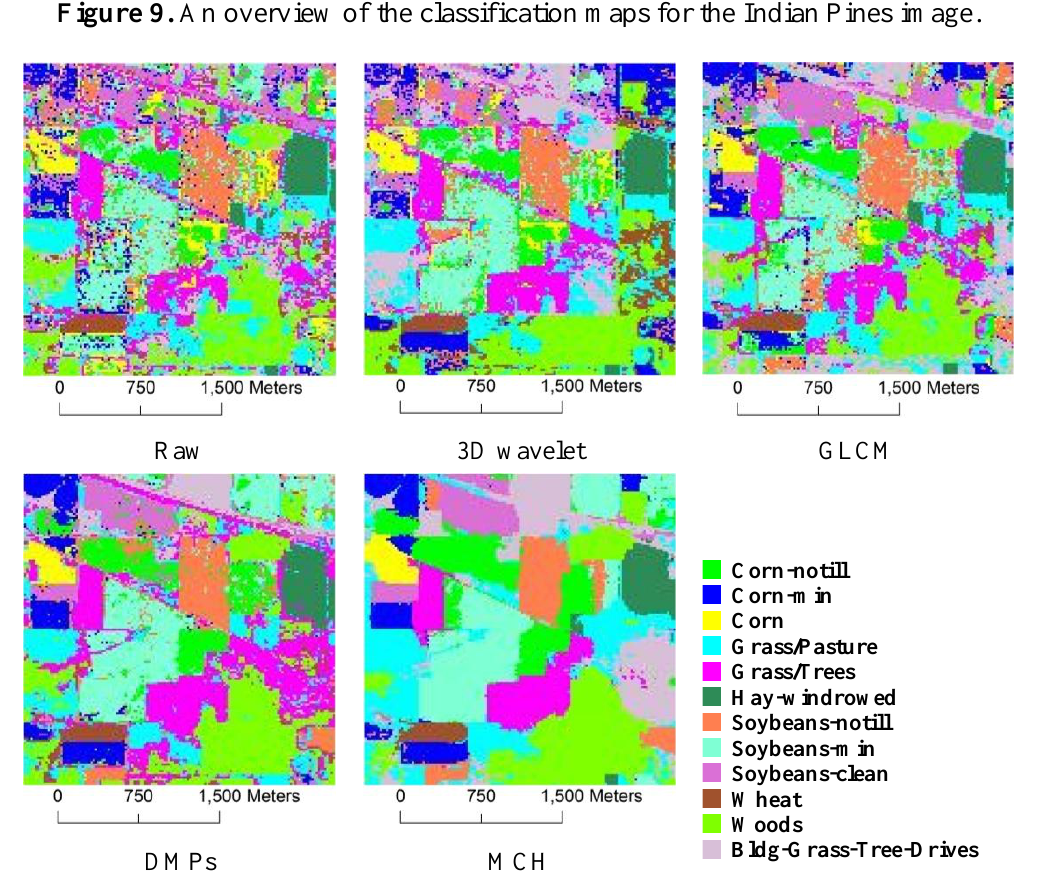
Figure 9. An overview of the classification maps for the Indian Pines